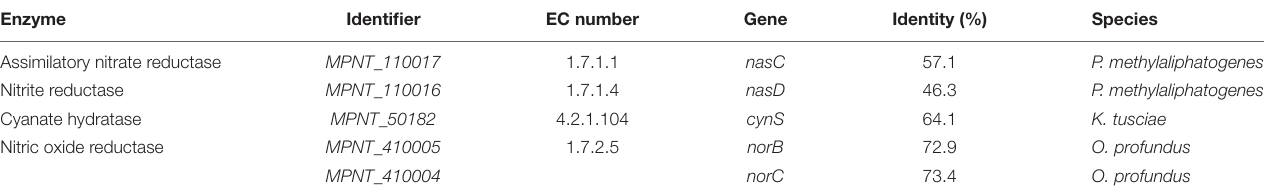
TABLE 5 | Genes encoding for enzymes involved in nitrogen metabolism, along with their Enzyme Commission (EC) numbers, and percentage identity to the most similar homologue.